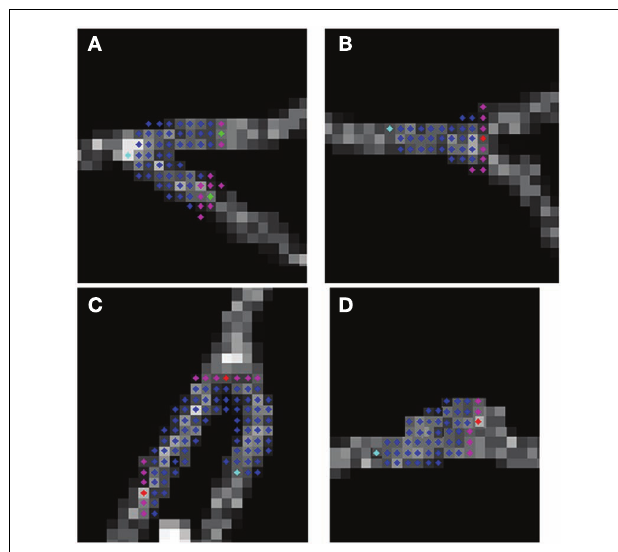
FIGURE 9 | Possible situations when algorithm initialize multi-scaling: (A–C) true positives; (D) false positive (false alarm).